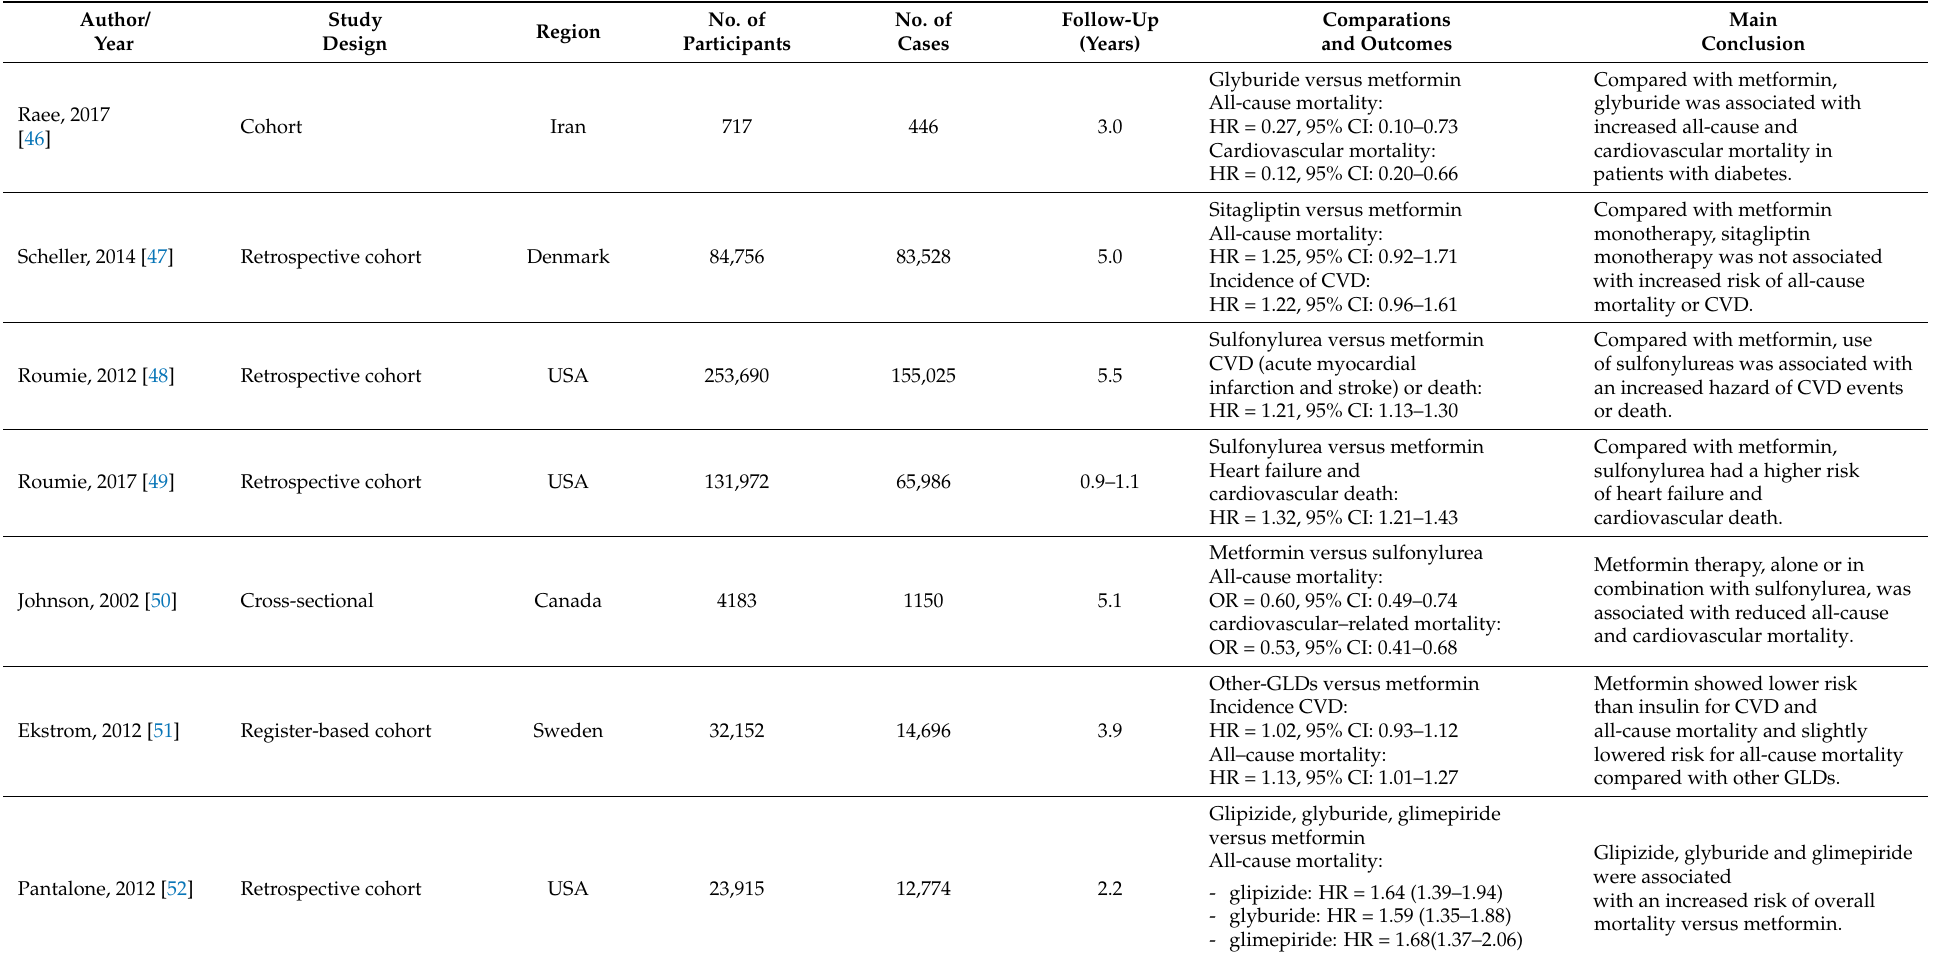
Table 1. Studies on the association of metformin use with clinical events in patients with type 2